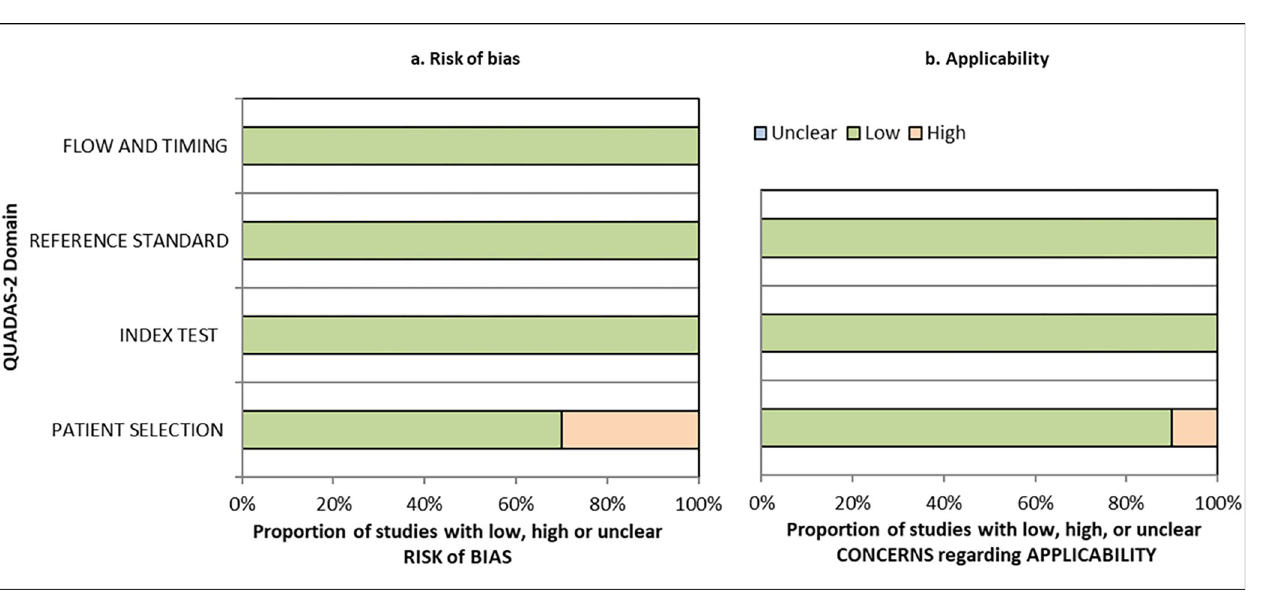
Fig 2. Proportion of studies assessed as low, high, or unclear risk of bias and applicability.